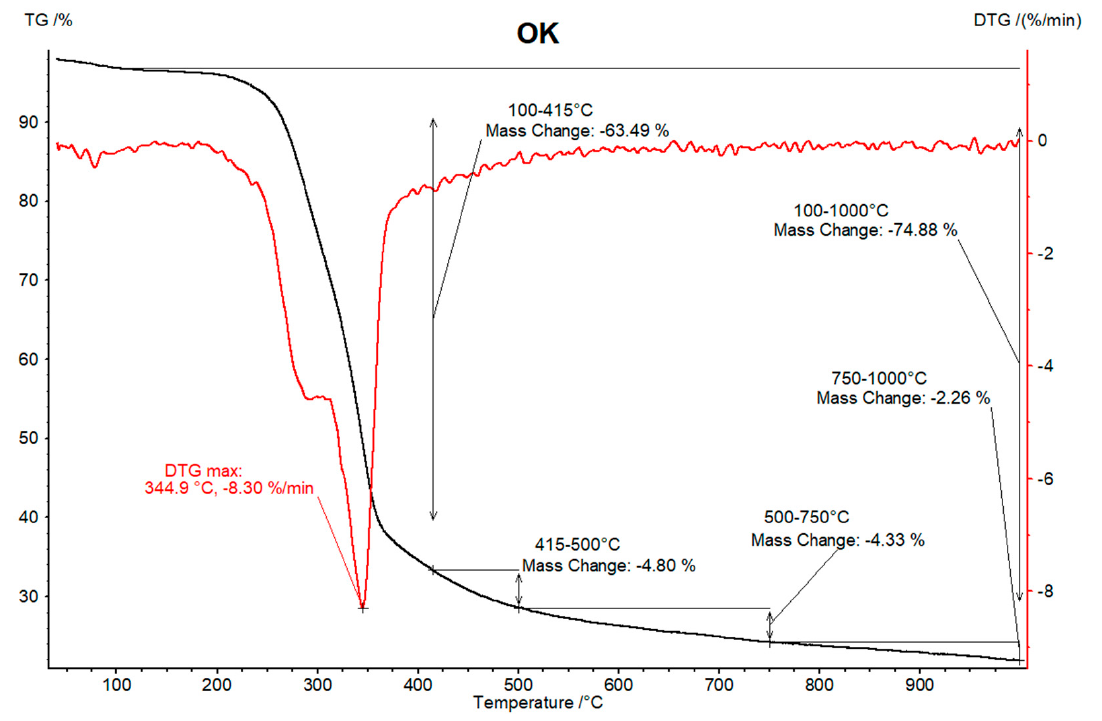
Figure A4. TG/DTG curves obtained for olive kernels.